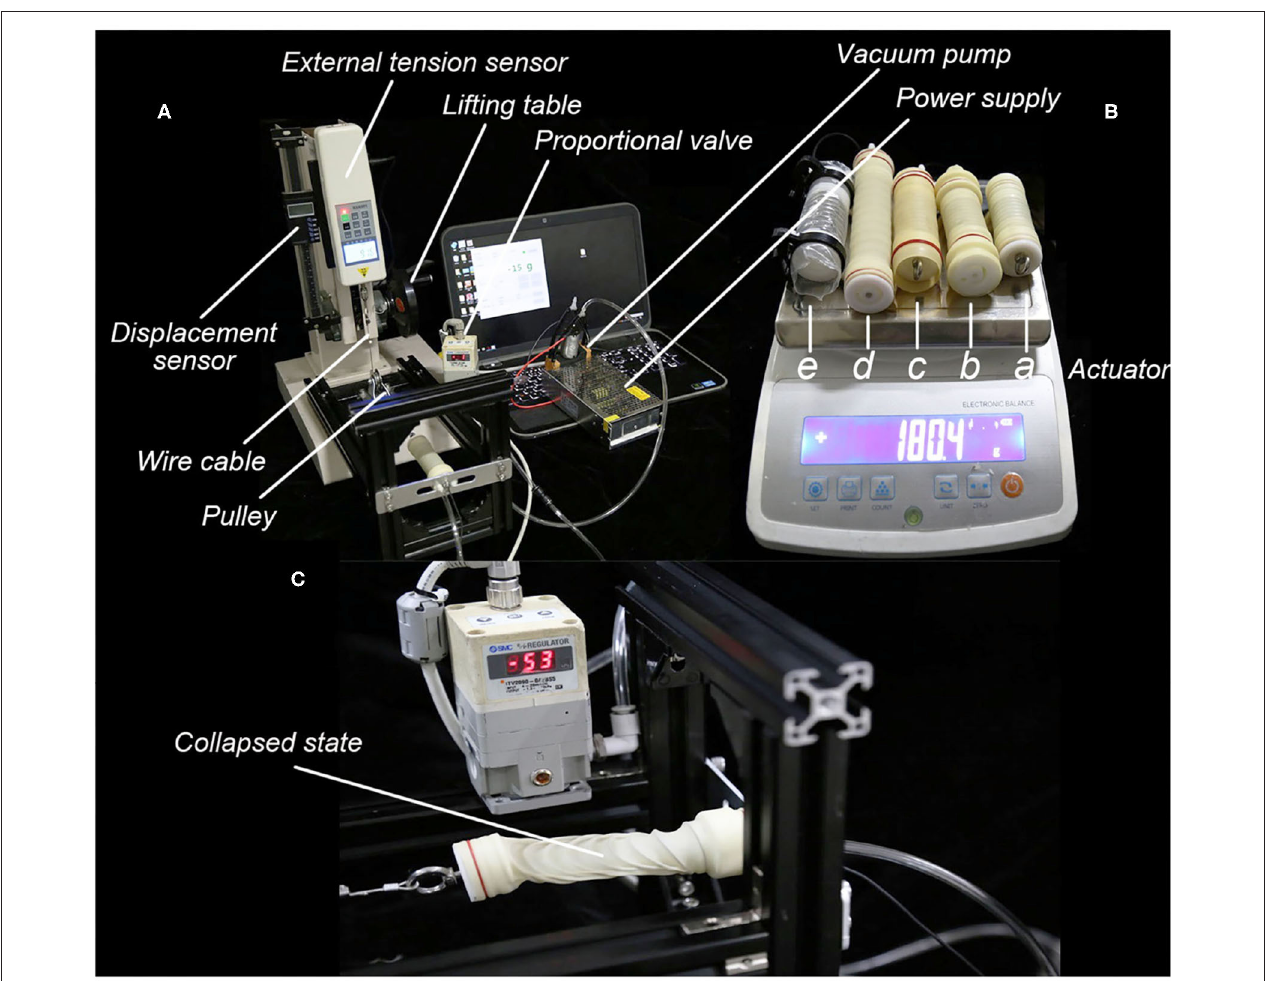
FIGURE 4 | The experimental setup and actuators for test. (A) The platform built to test the characteristics of Self-sensing Pneumatic Compressing Artificial Muscle (SPCAM), with the displacement sensor and the external tension sensor. (B) Five different actuators to be tested, with the average weight < 40 g. Actuator a, b, c, and d are made up of latex membrane with different thickness, while actuator e is made up of polyethylene film. Specific parameters are listed in Table 2 . (C) The collapse phenomenon of latex membrane actuator. When overstretched and under high negative pressure, the actuator collapses sidewise due to the unbalanced force, and is unable to work normally.